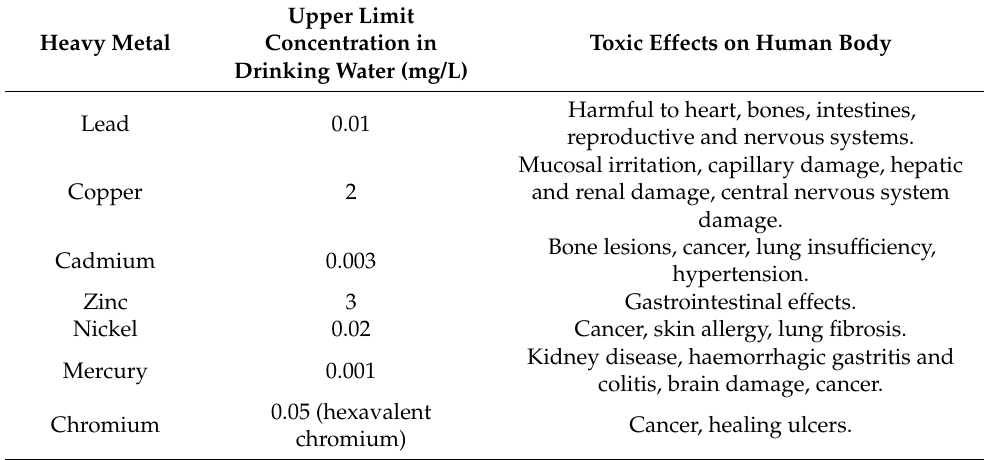
Table 1. Upper limit concentrations, according WHO in drinking water for some heavy metals and their harmful effects on the human body [4]. Upper Limit Heavy Metal Concentration